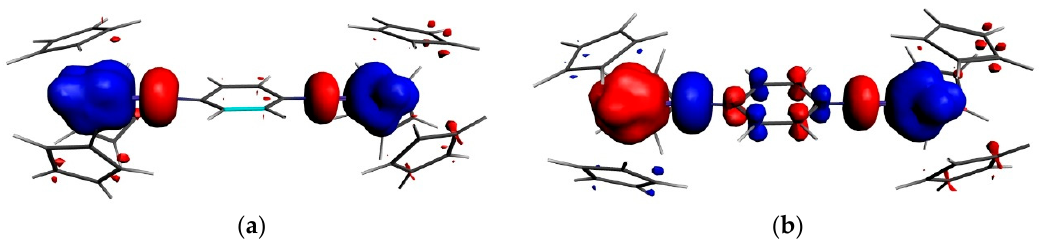
Figure 13. ZORA/B3LYP spin-density (difference of alpha and beta electron densities) distribution plots for the HS ( a ) triplet and BS ( b ) states of para-U2imido (blue color: positive spin density and red color: negative spin density) (reprinted with permission from [146], Elsevier, 2012).